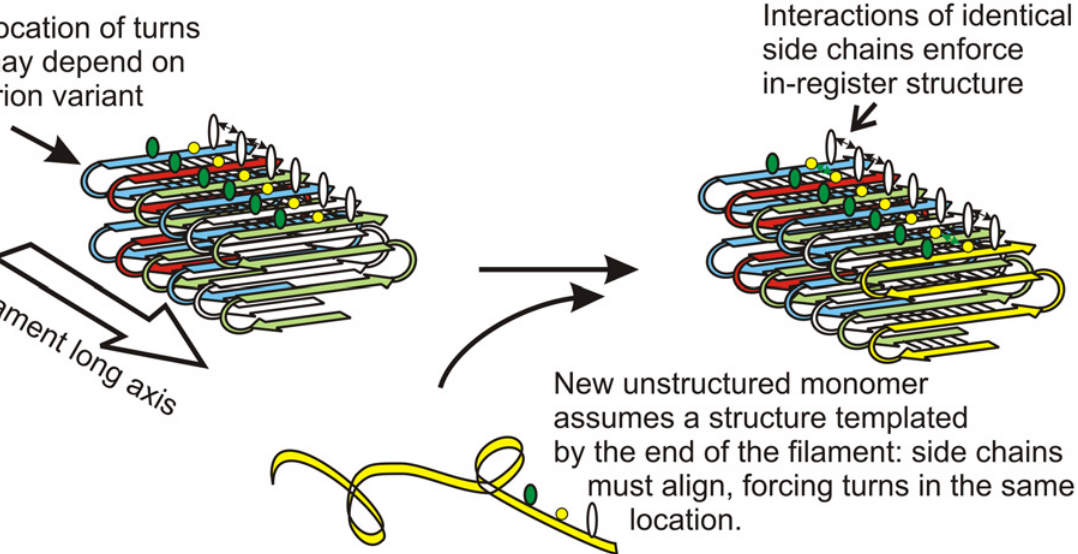
Fig 1. Protein conformation templating mechanism. The in-register parallel amyloid architecture naturally suggests a mechanism for transfer of conformation information from molecules in the filament to those joining the filament. H-bonding or hydrophobic favorable interactions among identical side chains require in-register alignment for the interactions. This directs the monomer joining the end of the filament to have its folds/turns at the same residues as previous molecules in the filament. Different prion variants have folds/turns at different locations, but each is faithfully propagated by this mechanism. Modified from